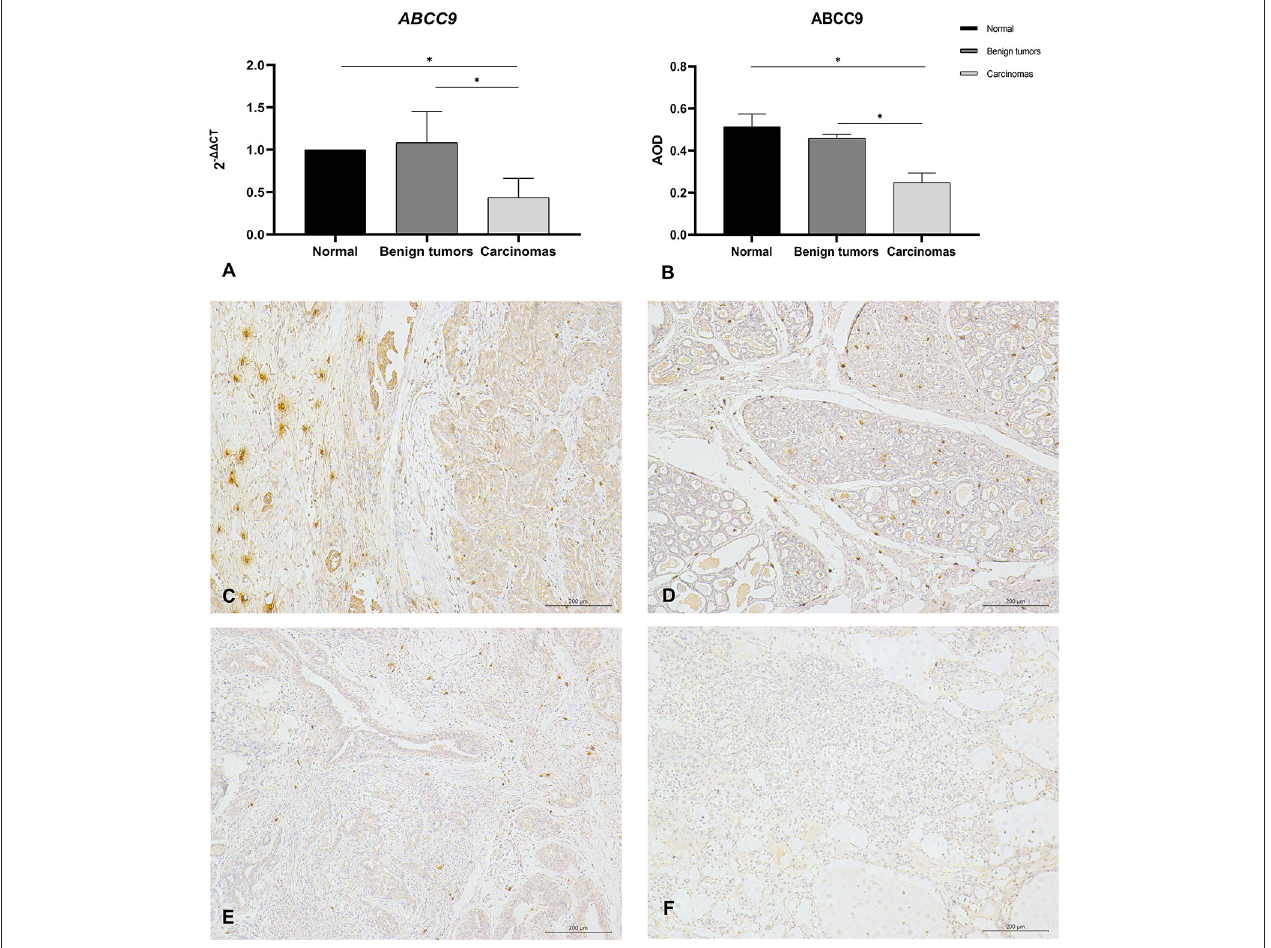
FIGURE 4 | The mRNA level and protein expression of ABCC9. (A) The mRNA level of ABCC9, the mRNA level was expression by 2 − 11 Ct . (B) Average optical density values of ABCC9 protein in CMTs. AOD = IOD/Area, all of data are shown as means ± SD, * indicates that there is significant difference between two groups ( P < 0.05). (C) IHC staining of ABCC9 in paracancer tissue (200 × ). (D) IHC staining of ABCC9 in benign tumor (200 × ). (E) IHC staining of ABCC9 in complex breast cancer (200 × ). (F) No strong positive staining of ABCC9 in higher malignancy cells (200 × ). Strongly positive cells can be observed in para-cancer tissues and benign tumors, but was significant decreased in malignant